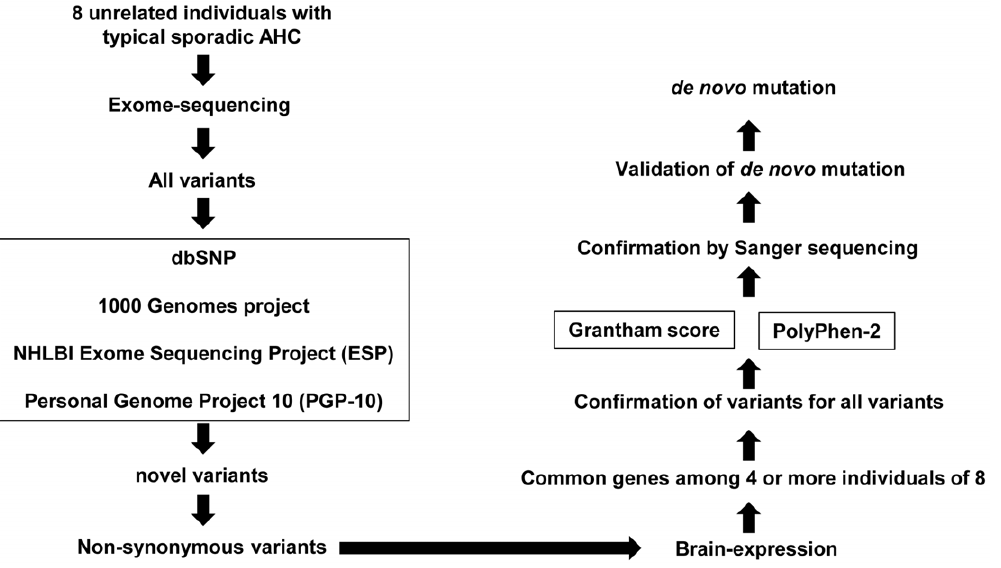
Figure 1. Pipeline for detection of novel de nov o mutations. The pipeline was used to identify pathogenic mutations of alternating hemiplegia of childhood (AHC). All genetic variants detected by exome sequencing are sequentially filtered through the pipeline. First, variations are screened according to databases of registered single nucleotide polymorphisms (SNP) and only non-registered SNP undergo the next selection as ‘‘Novel variants’’. In the next step, non-synonymous novel variants of genes expressed in the central nervous system are selected. When variations of the same gene are found in the patient, the impact of such variation is evaluated in silico using Grantham score and PolyPhen-2. Mutations identified at this stage are reconfirmed by Sanger sequence. De novo mutation is validated by analyzing samples from parents. Mutations considered pathogenic are sought in other patients with AHC if necessary.